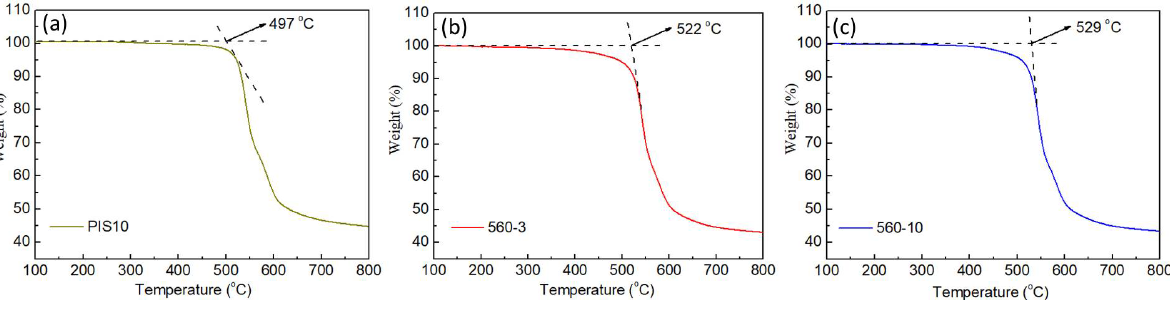
Figure 5. TGA curves of PIS10 ( a ), PIS10-560-3 ( b ) and PIS10-560-10 ( c ). It can be seen that the heat stability of the film enhances slightly with the improved with the addition of KH-560. This is because the epoxy group at the end of the KH-560 molecule is hydrolyzed to form a hydroxyl group, and a part of the hydroxyl group un- dergoes an esterification reaction with the carboxyl group in the PAA molecule, de- creasing the molecular weight and the viscosity of the system, which is more conducive to the dispersion of the inorganic phase in the PI. The viscosity decreases and the degree of freedom of PI molecular chain movement increases, which also increases the chance of reaction with the inorganic phase. Abundant Si-OH on the surface of the SiO 2 nanoparti- cles has a strong adsorption effect on the organic phase, which inhibits the thermal vi- bration of polyimide to a certain extent. Thereby it is beneficial to enhance heat stability.